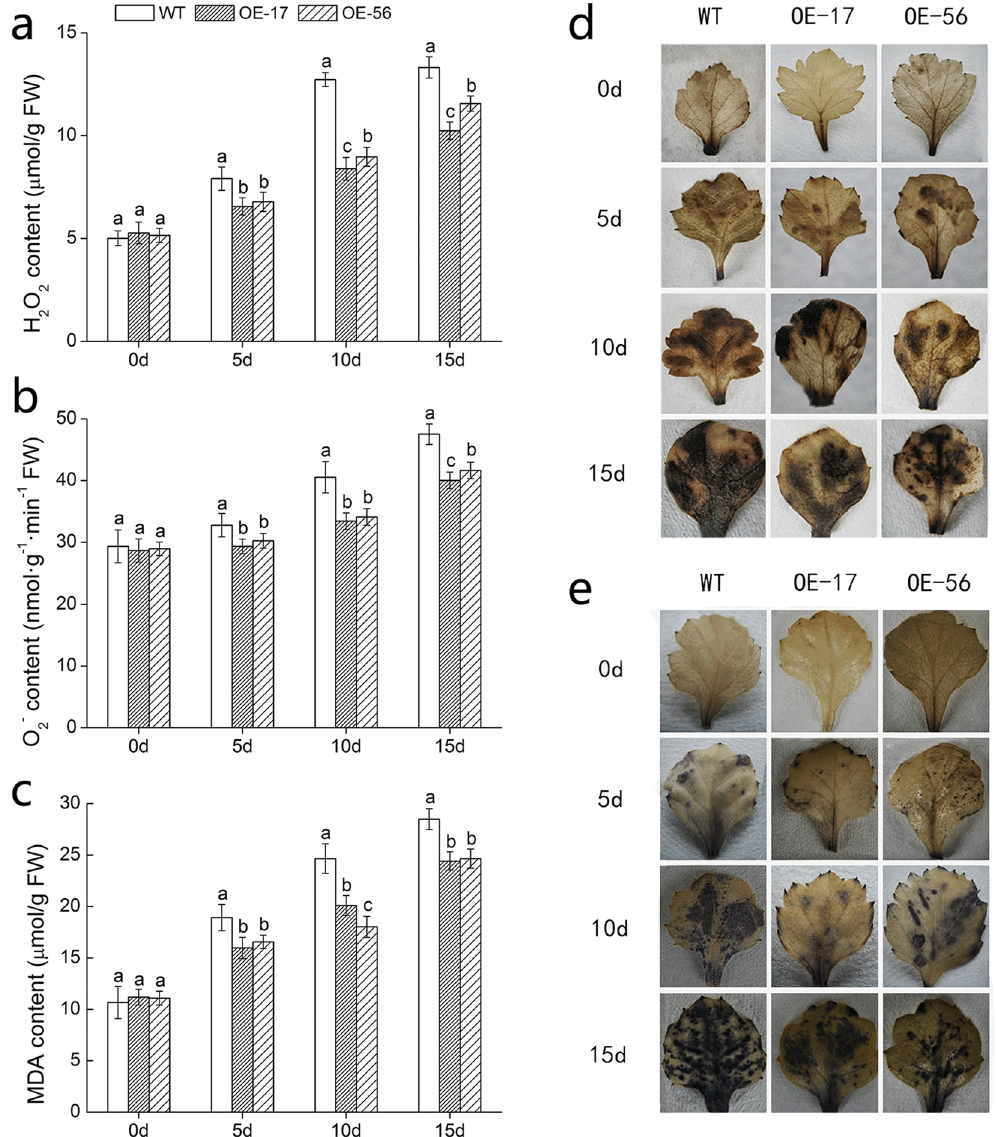
Figure 3. Analysis of H 2 O 2 , O 2 − and MDA in DgWRKY5 transgenic lines and WT under salt stress. ( a ) H 2 O 2 . ( b )